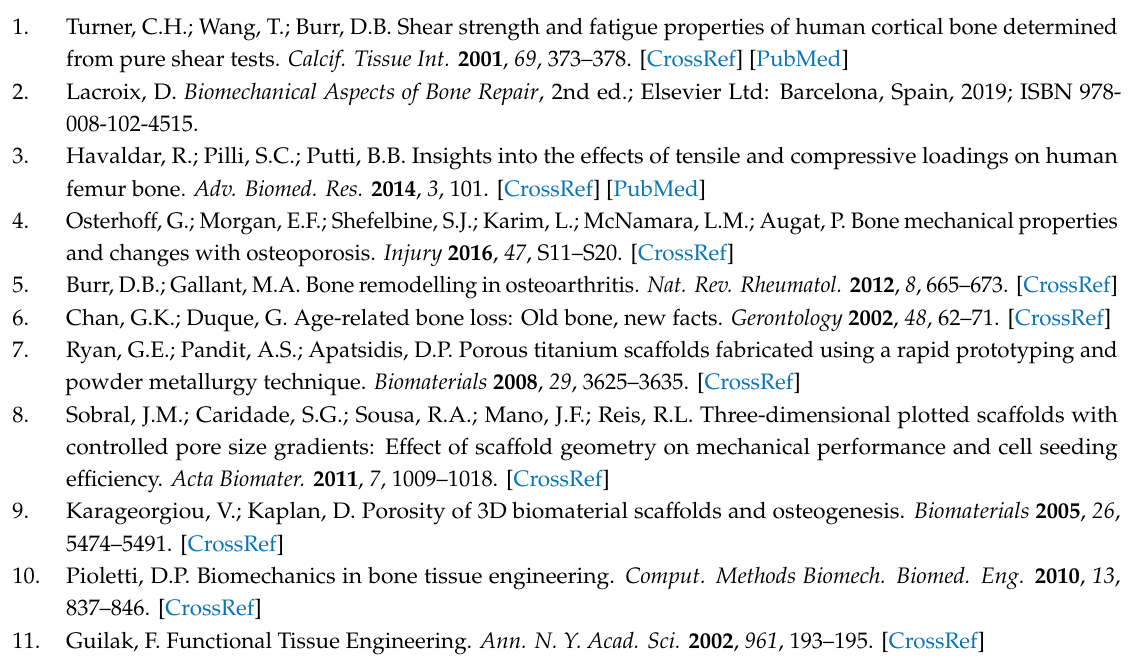
Figure S1: EDS data presenting the elements distribution upon the surfaces of (a) CP-Ti, (b) CP-Ti 10_45 , (c) CP-Ti 20_45 , (d) CP-Ti Figure S3: AFM topographical images illustrating for the surfaces of (a) CP-Ti, (b) CP-Ti 10_45 , (c) CP-Ti 20_45 , (d) CP-Ti 20_55 (e) CP-Ti 20_65 , and (f) CP-Ti 30_65